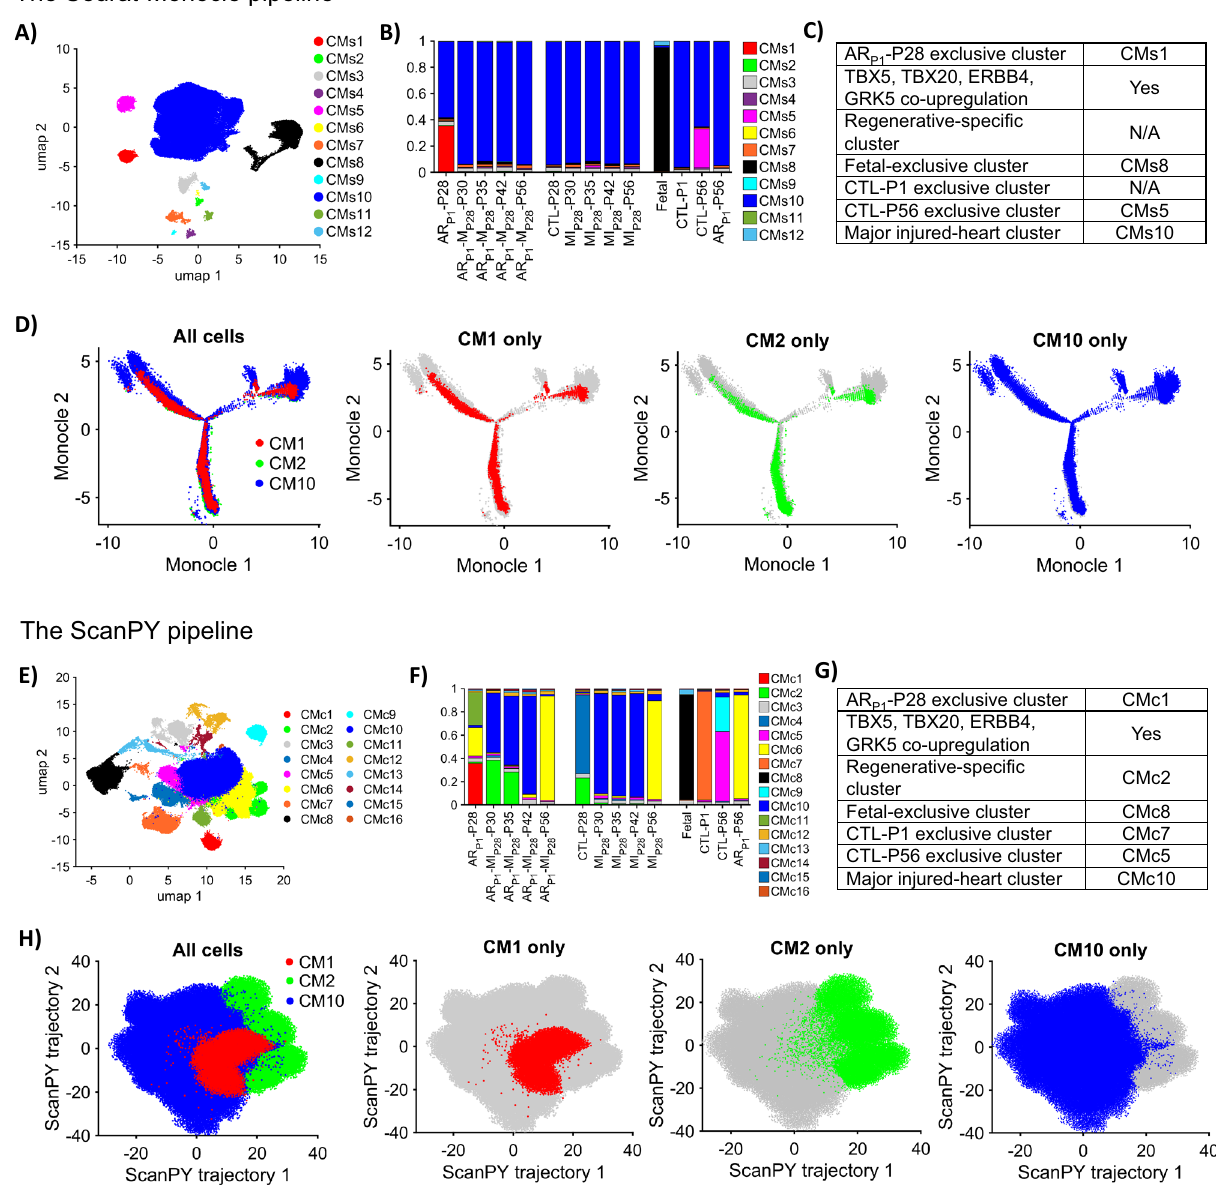
Figure 5. AI semisupervised learning was more effective than non-AI tools for trajectory analysis of cardiomyocyte scRNAseq data from pig hearts ( A ) Seurat-Monocle pipeline UMAP plot visualizing 12 cardiomyocyte clusters (CMs1-CMs12), where these clusters were identified by Seurat pipeline 30 . ( B ) The proportion of cardiomyocytes from each cluster CMs1-CMs12 is displayed for each injury group and time point. ( C ) Summary of clusters resulting from the Seurat-Monocle pipeline that are: exclusive for ARp1-P28, Fetal, CTL-P1, CTL-P56, and co-upregulation of TBX5/TBX20/ERBB4/GRK5, which do not show any clusters explicit for ARP1-MIP28 cardiomyocytes on P30, P35, and P42. ( D ) Seurat-Monocle pipeline trajectory plot among CM1, CM2, and CM10, whereas CM1, CM2, and CM10 were defined in 40 . ( E ) ScanPY pipeline UMAP plot visualizing 16 cardiomyocyte clusters (CMc1-CMc16) identified by ScanPY. ( F ) The proportion of cardiomyocytes from each cluster CMc1-CMc12 is displayed for each injury group and time point. ( G ) ScanPY pipeline, a summary of clusters that are: exclusive for ARp1-P28, Fetal, CTL-P1, CTL-P56, and co-upregulation of TBX5/TBX20/ERBB4/GRK5. ( H ) ScanPY pipeline trajectory plot among CM1, CM2, and CM10. For comparison, the figures for the AI-based method were available at 40